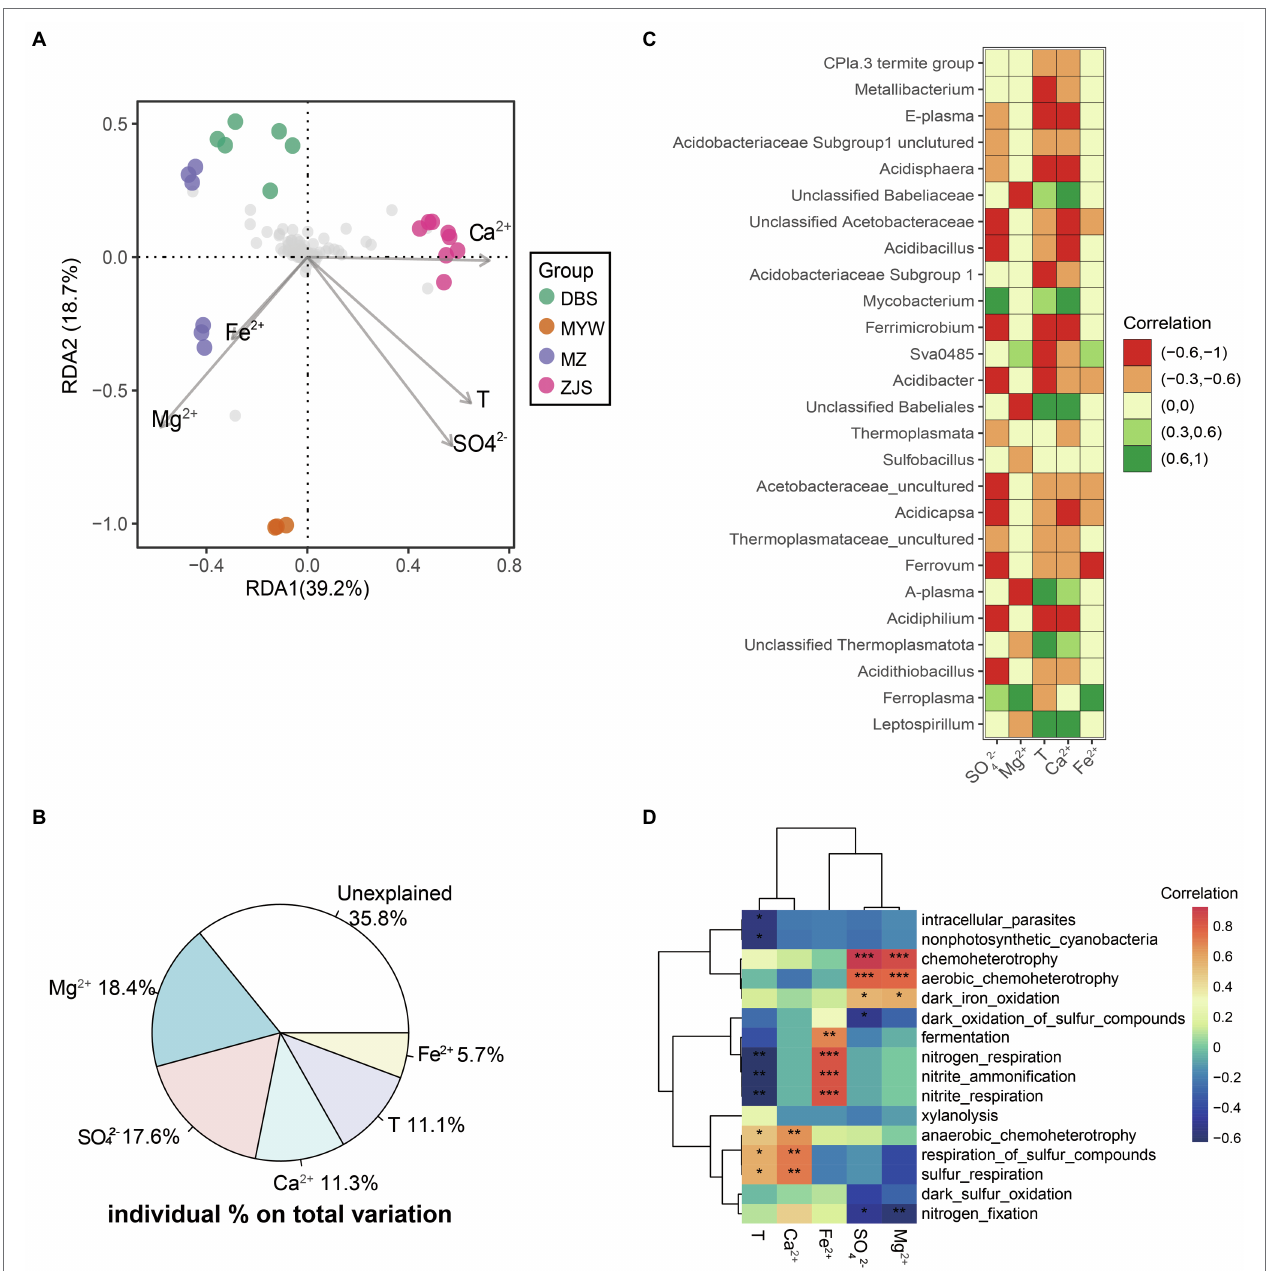
FIGURE 3 | Environmental factors determining AMD microbial community structure. (A) db-RDA of microbial communities. Abundance data were Hellinger- standardized. (B) Variation partition of key contributing factors on dissimilarity of microbial communities. (C) Pearson correlations ( p < 0.01) between abundant taxa and most important environmental factors. (D) Heatmaps of Pearson correlations between predicted functions of microbial communities and determining environmental factors in AMD. * p < 0.05, ** p < 0.01, *** p <